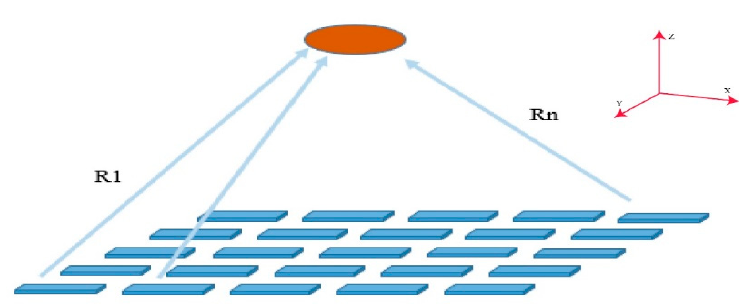
Figure 1. Rectangular distribution array diagram.